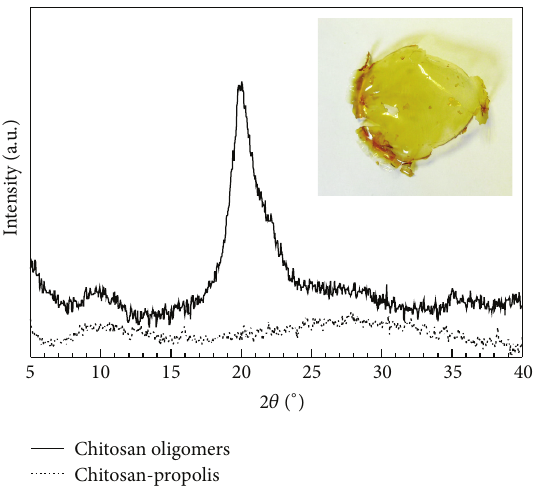
Figure 2: X-ray powder diffraction pattern for chitosan oligomers (solidline)andchitosanoligomers/propoliscomposite(dottedline). The inset shows a photograph of the chitosan oligomers/propolis